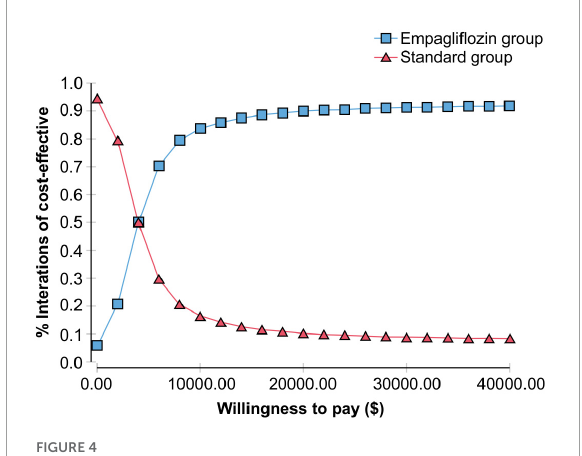
FIGURE4 Cost-effectiveness acceptability curve showing the willingness to pay and the corresponding probability of cost-effectiveness for the empagliflozin group vs. standard group.